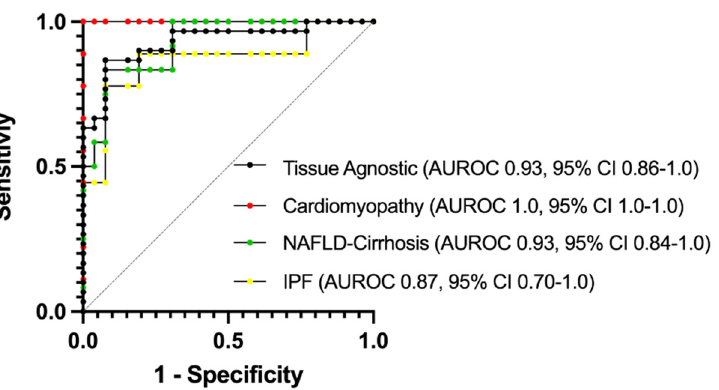
Figure 7. AUROC analysis of plasma PNC for specificity and sensitivity. Normal donor samples ( n = 26) were compared to samples from cardiomyopathy (Red, n = 9), NAFLD-Cirrhosis (Green, n = 12) and IPF (Yellow, n = 9) patients. To determine tissue-agnostic AUROC, all fibrotic samples were combined (Black, n = 30) and compared to normal donor samples. AUROC = area under the receiver operating characteristics curve.